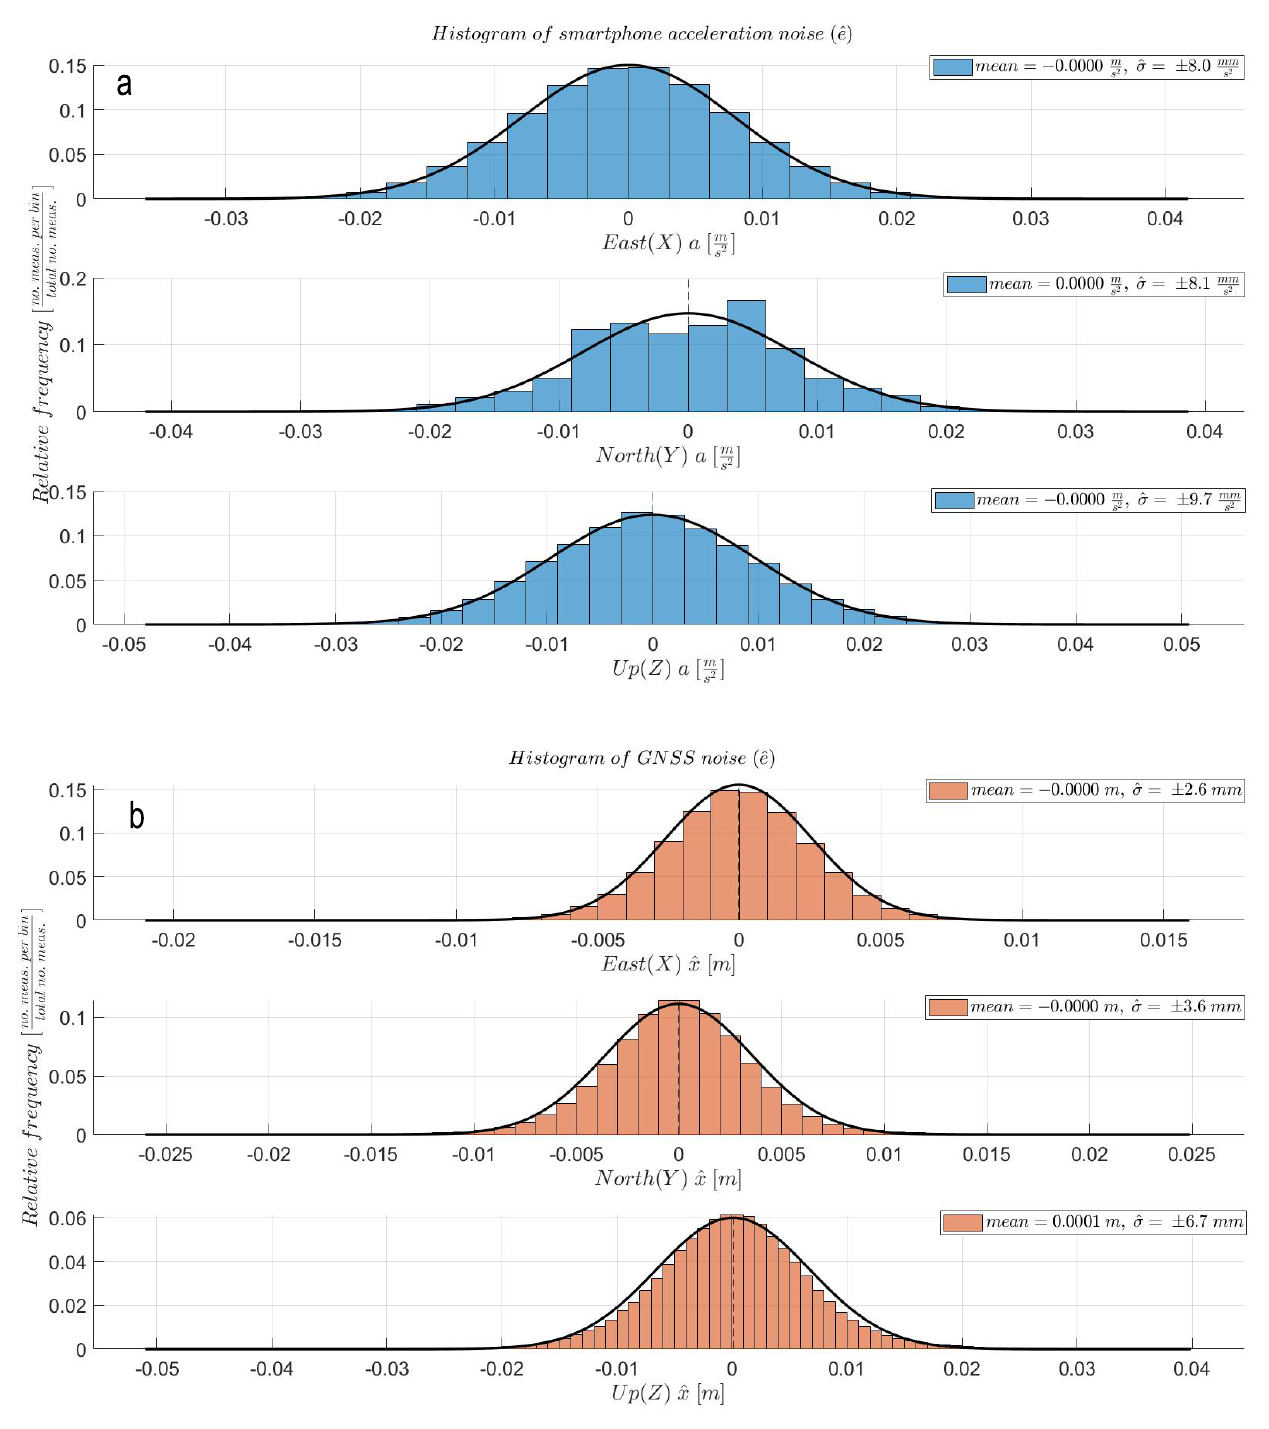
Figure A3. Visual analysis of the statistical distribution of the ( a ) Smartphone accelerometer and ( b ) GNSS noise data sets. Both sets of histograms generally fit the shape of the formal normal distribution curves in black (with empirical mean and standard